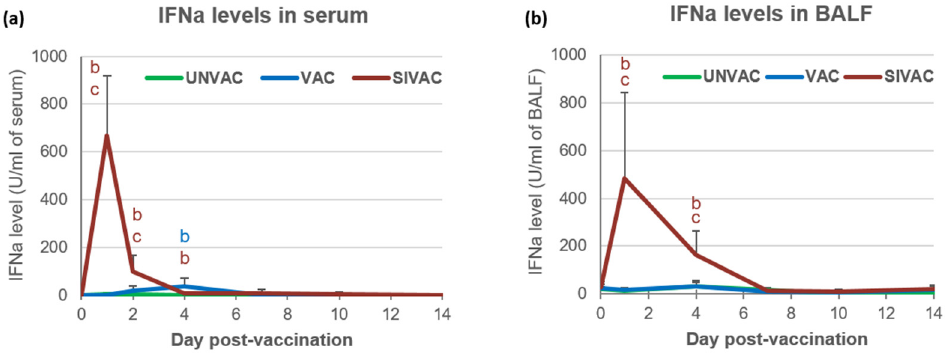
Figure 4. Interferon alpha (IFNa) levels quantified in ( a ) serum or ( b ) BALF. Data are reported as the mean (± SD) of the results obtained from all piglets in each group. Different letters (b,c) indicate that the considered group (specified by its color) was significantly different from the UNVAC group (b) or from the VAC group (c) with p < 0.05.